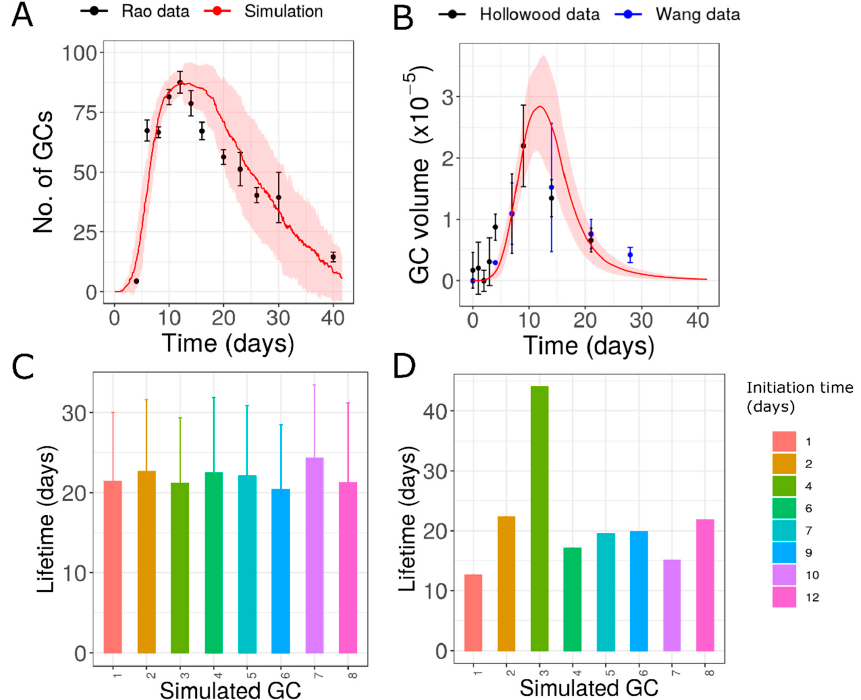
Figure 6. Simulations of GCs with different initial antigen concentrations independent of starting time: ( A ) dynamics of number of GCs, ( B ) total GC Volume, ( C ) lifetime of simulated GCs as an average of 60 simulations, ( D ) lifetime of simulated GCs in a single simulation. Experimental data from [13,31,45]. Color code in panels C and D, represent the initiation time of GCs. GC: Germinal Center.